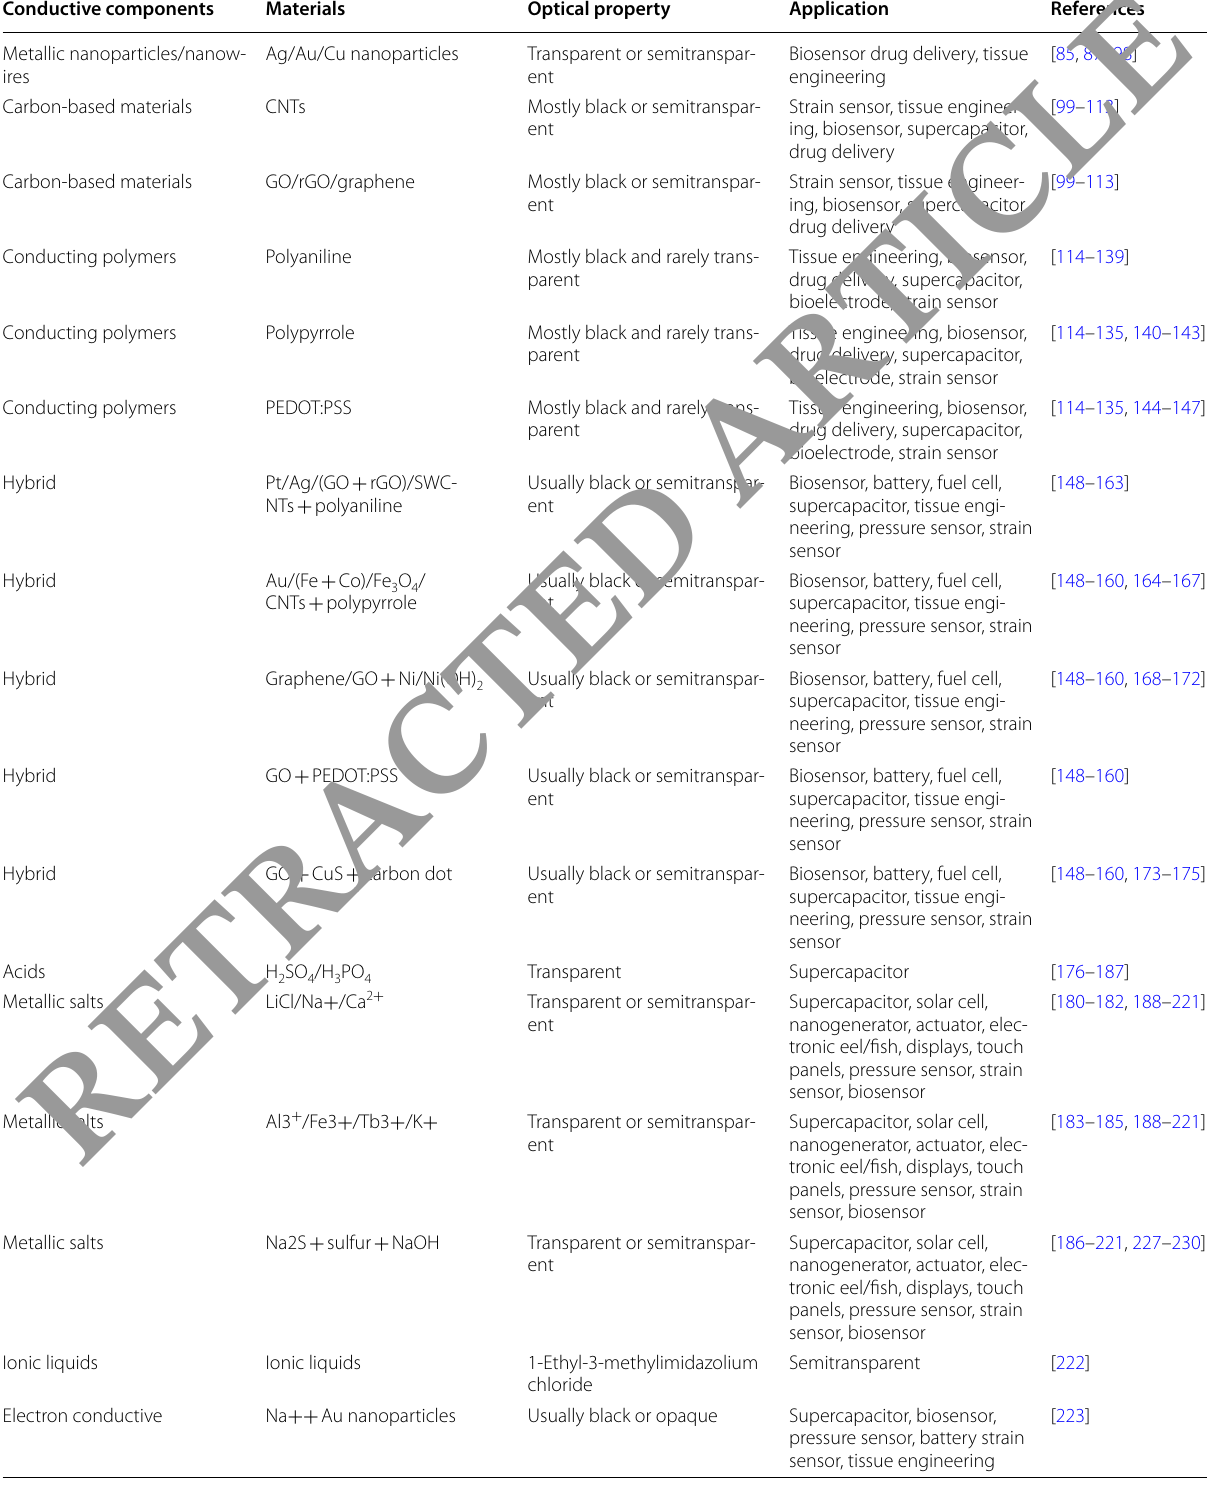
Table 1 Summary of properties and nanoelectronic applications of conductive gels Conductive